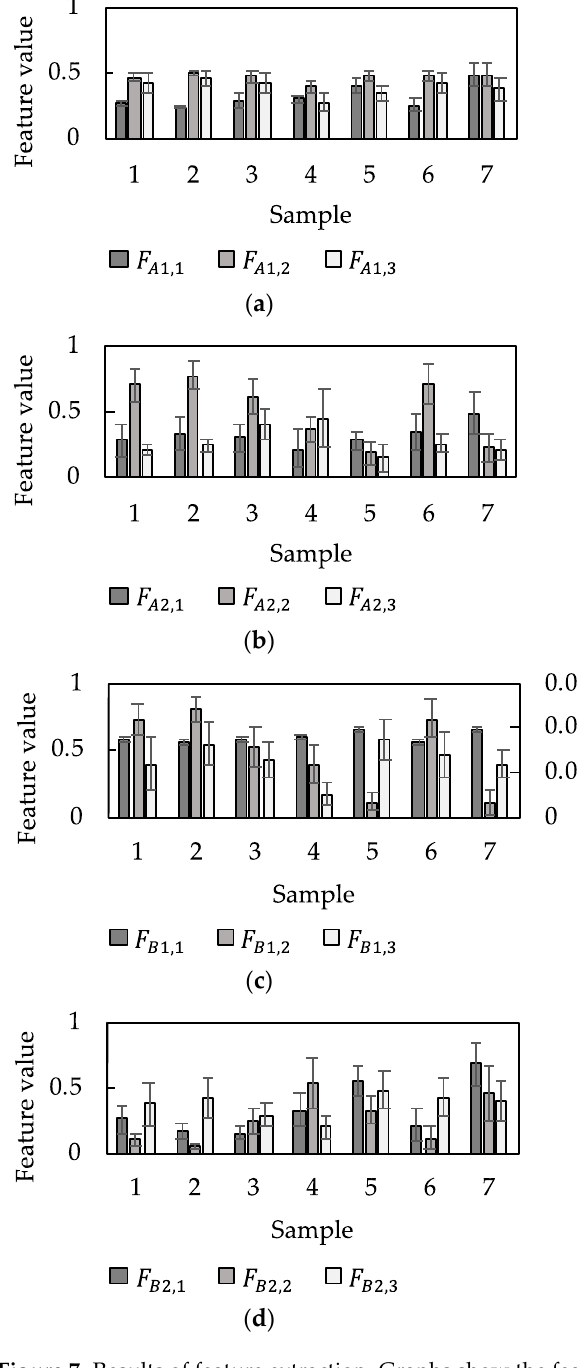
Figure 7. Results of feature extraction. Graphs show the feature values for ( a ) A1, ( b ) A2, ( c ) B1, and ( d ) B2 ( n = 3610, mean ± SD ). The vertical axis on the right in ( c ) gives the value of F B 1,1 . Table 6. Error in applying the trained deep autoencoder to the test data.